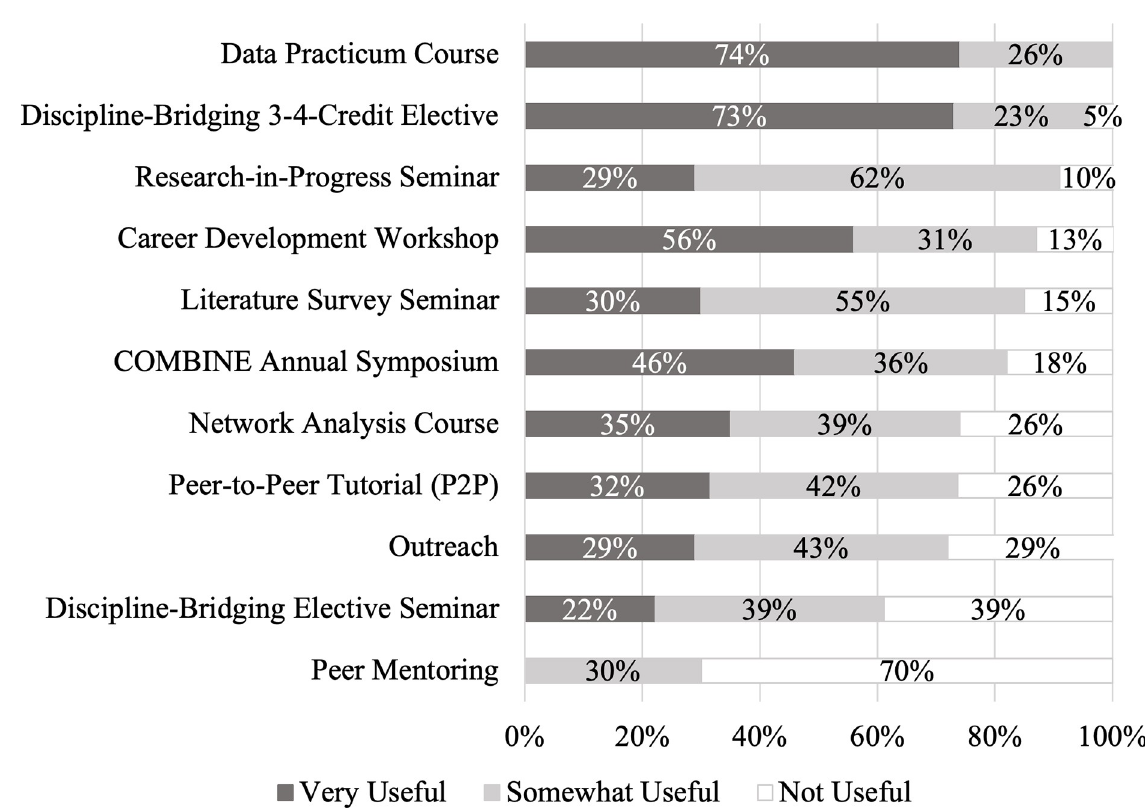
Fig 5. Student ratings of the usefulness of COMBINE components. Note . Percentages were calculated out of the total number of students who participated in each component: Data Practicum Course ( n = 23), Discipline Bridging 3-4-Credit Elective ( n = 22), Research-in-Progress Seminar ( n = 21), Career Development Workshop ( n = 16), Literature Survey Seminar ( n = 20), COMBINE Annual Symposium ( n = 22), Network Analysis Course ( n = 23), Peer-to-Peer Tutorial (P2P; n = 19), Outreach ( n = 21), Discipline-Bridging Elective Seminar ( n = 18). Only students in the second cohort were asked about the usefulness of Peer Mentoring ( n = 10). Percentages may sum to greater than 100% due to rounding.